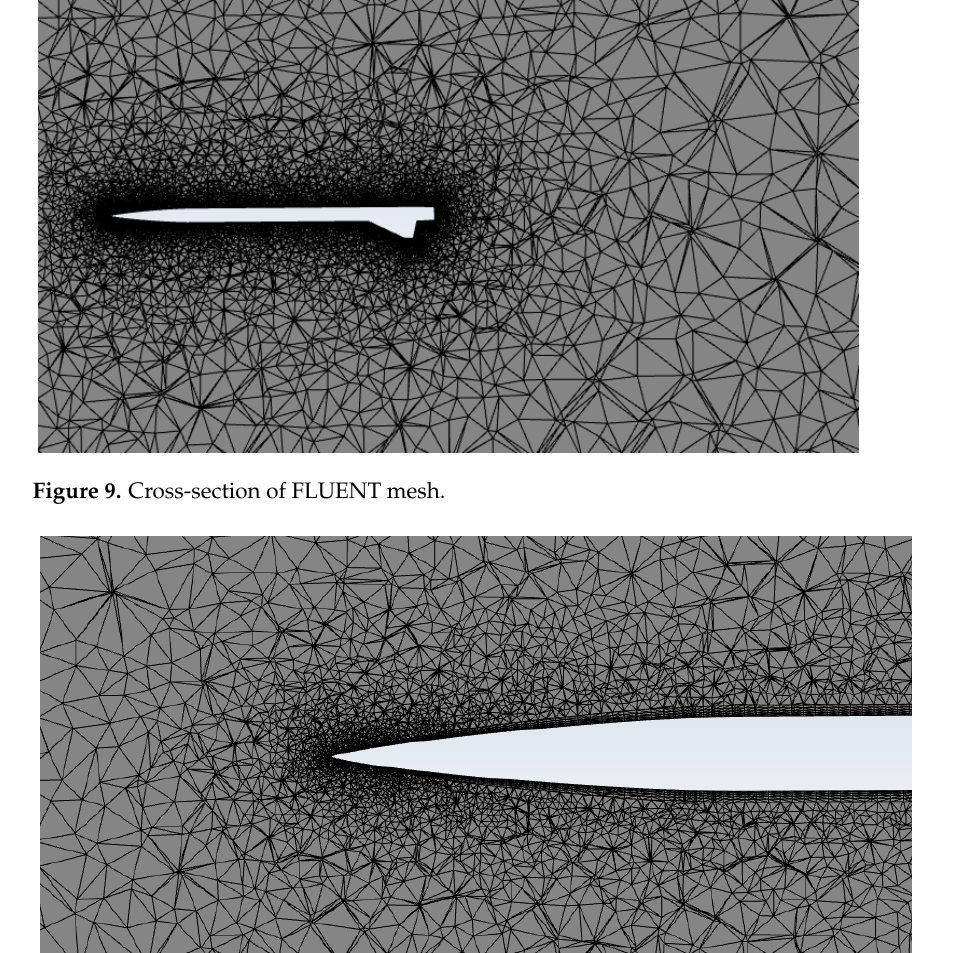
Figure 10. FLUENT mesh at nosecone.